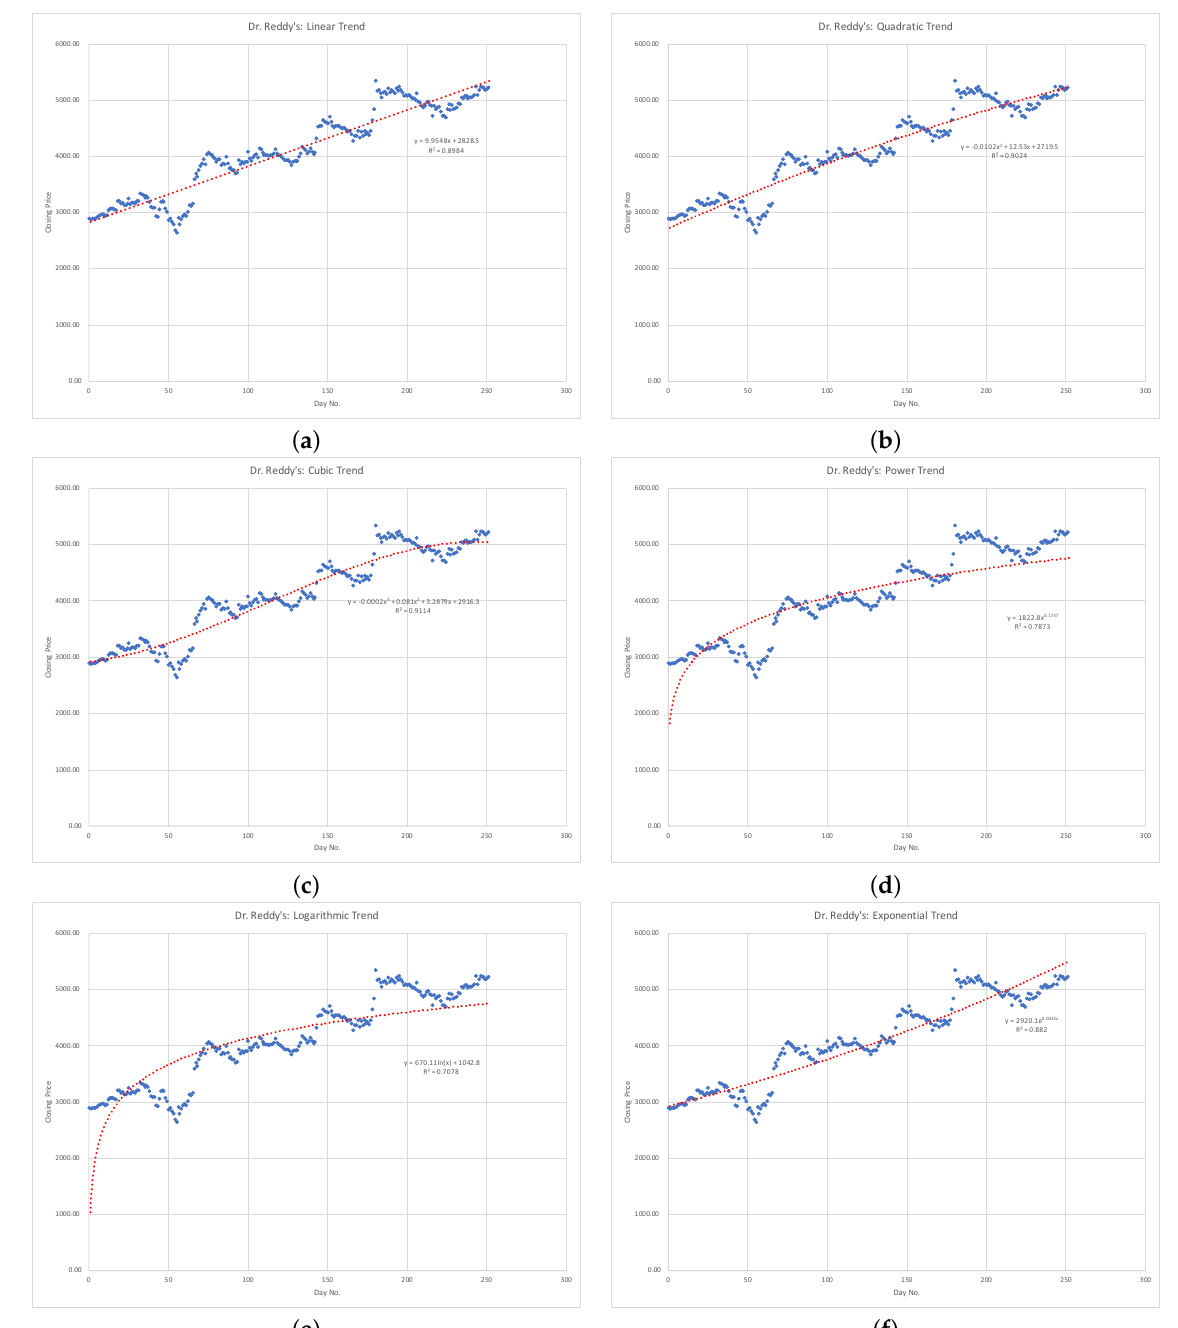
Figure 1. Trend lines for Dr. Reddy’s Lab (Pharma Sector): January–December 2020. The equation of the fitted trend line, R-squared error, RMS Error were calculated and are presented in Table 1. The same process was carried out for all the 20 companies, but for the sake of brevity, we display only